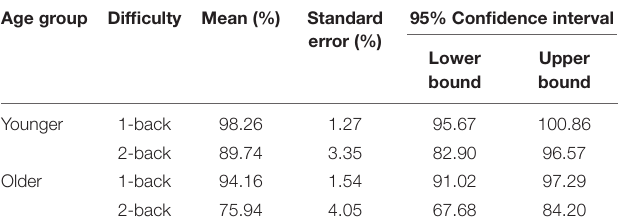
TABLE 2 | Cognitive accuracy: age by difficulty interaction.